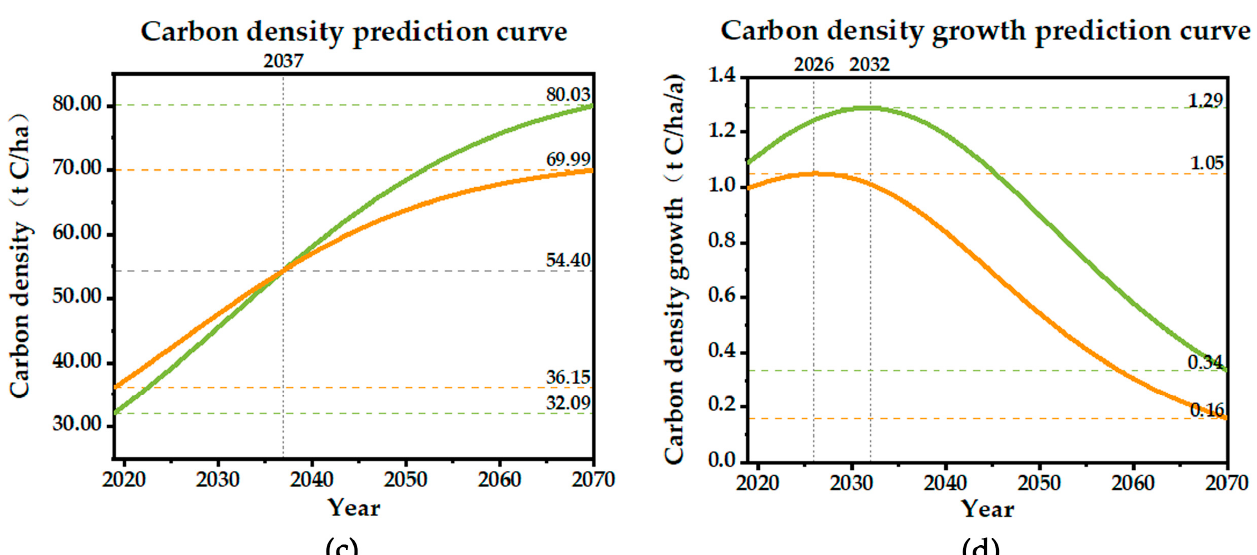
Figure 6. Carbon sequestration potential of natural and planted forests in Lushan City from 2019–2070: ( a ) shows the change of carbon stock, the two curves show an upward trend of decreasing growth rate, and the natural forest curve is always above the planted forest; ( b ) shows the change of annual carbon sink, the two curves show an increasing and then decreasing trend; ( c ) shows the change of carbon density, the two curves show an upward trend, and the natural forest carbon density exceeds the planted forest in 2040. ( d ) is the change of carbon density growth rate, and the change trend is similar to ( b ).